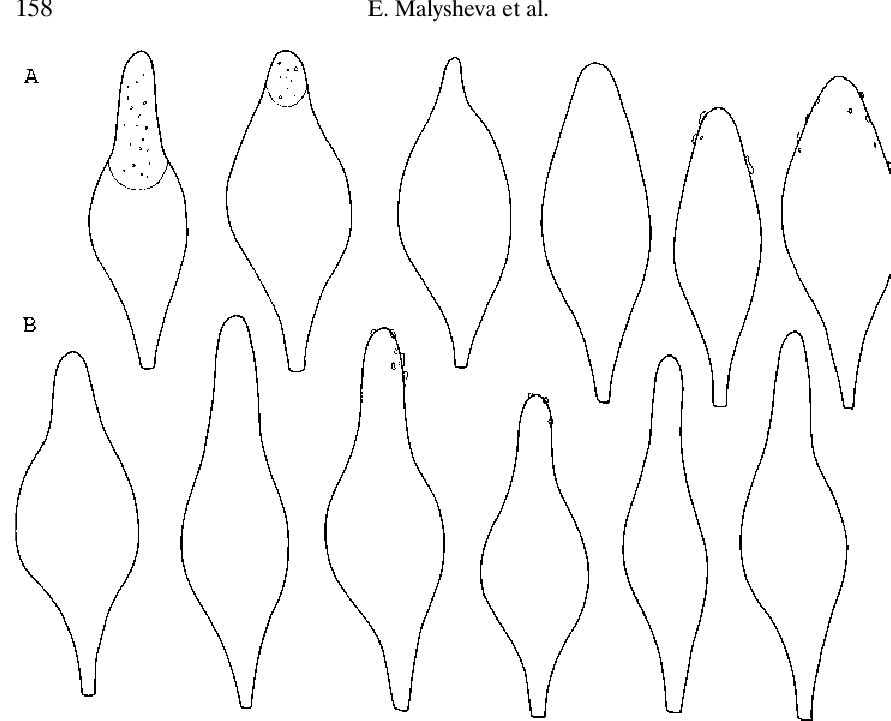
Fig. 5. Pluteus fenzlii (lE 246083): a – cheilocystidiogram, B – pleurocystidiogram; s cale bar = 10